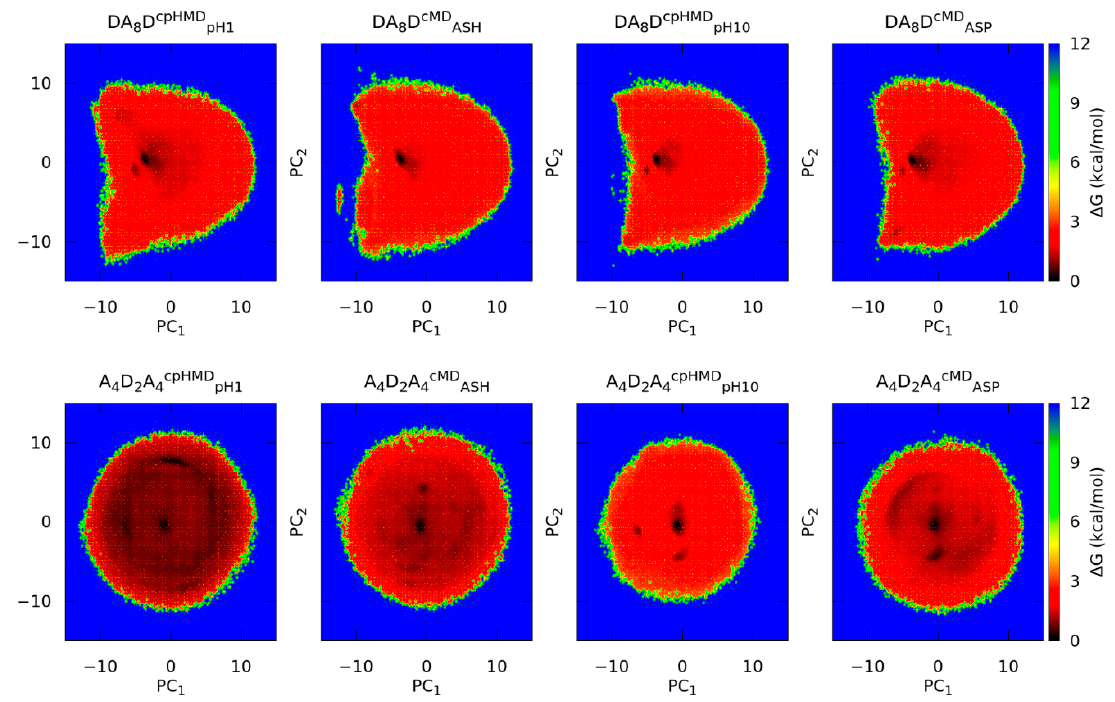
Figure 5. Gibbs free energies in the Principal Component space of the oligopeptides. The four plots in the top correspond to DA 8 D peptide and the four in the bottom correspond to the A 4 D 2 A 4 peptide. The subtitle of each graph indicates the peptide system, the simulation method (in the superscript), and the residue label or the pH (in the subscript) of the energy map. The PC spaces of the systems were built independently of each other.